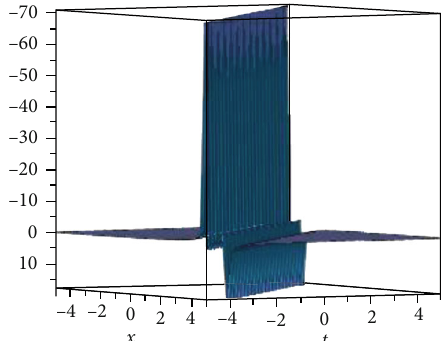
ð z Þ for the fi xed values v = 1 , z r ,2